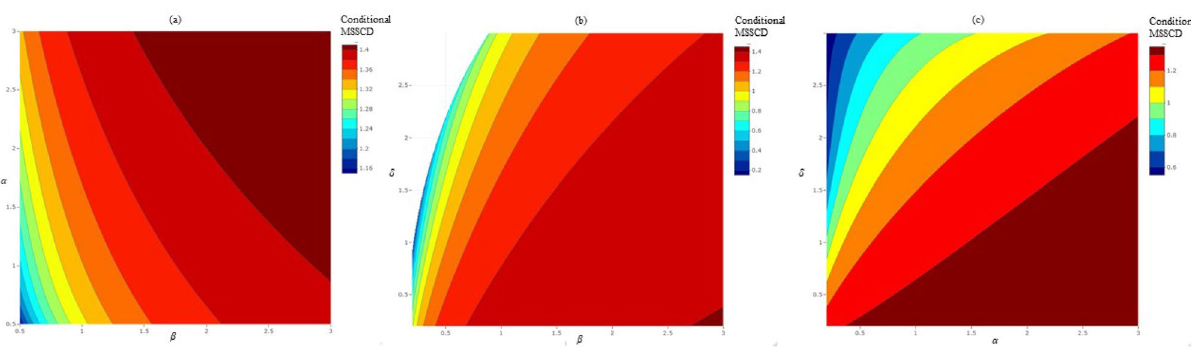
Figure 5. The distribution of the conditional MSSCD in parametric plane of regulators in the growth law: ( a ) dependence of the conditional MSSCD on α and β parameters; ( b ) dependence of the conditional MSSCD on δ and β parameters; ( c ) dependence of the conditional MSSCD on α and δ parameters.